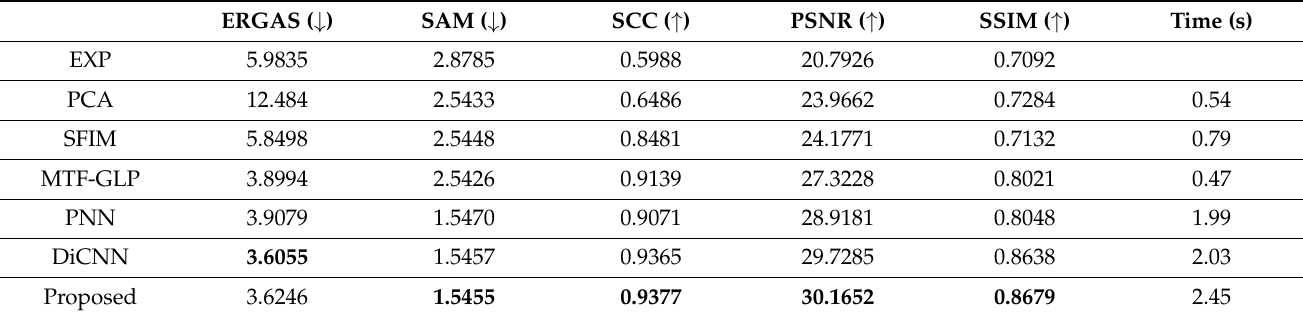
Table 1. Quantitative results of the Worldview-2